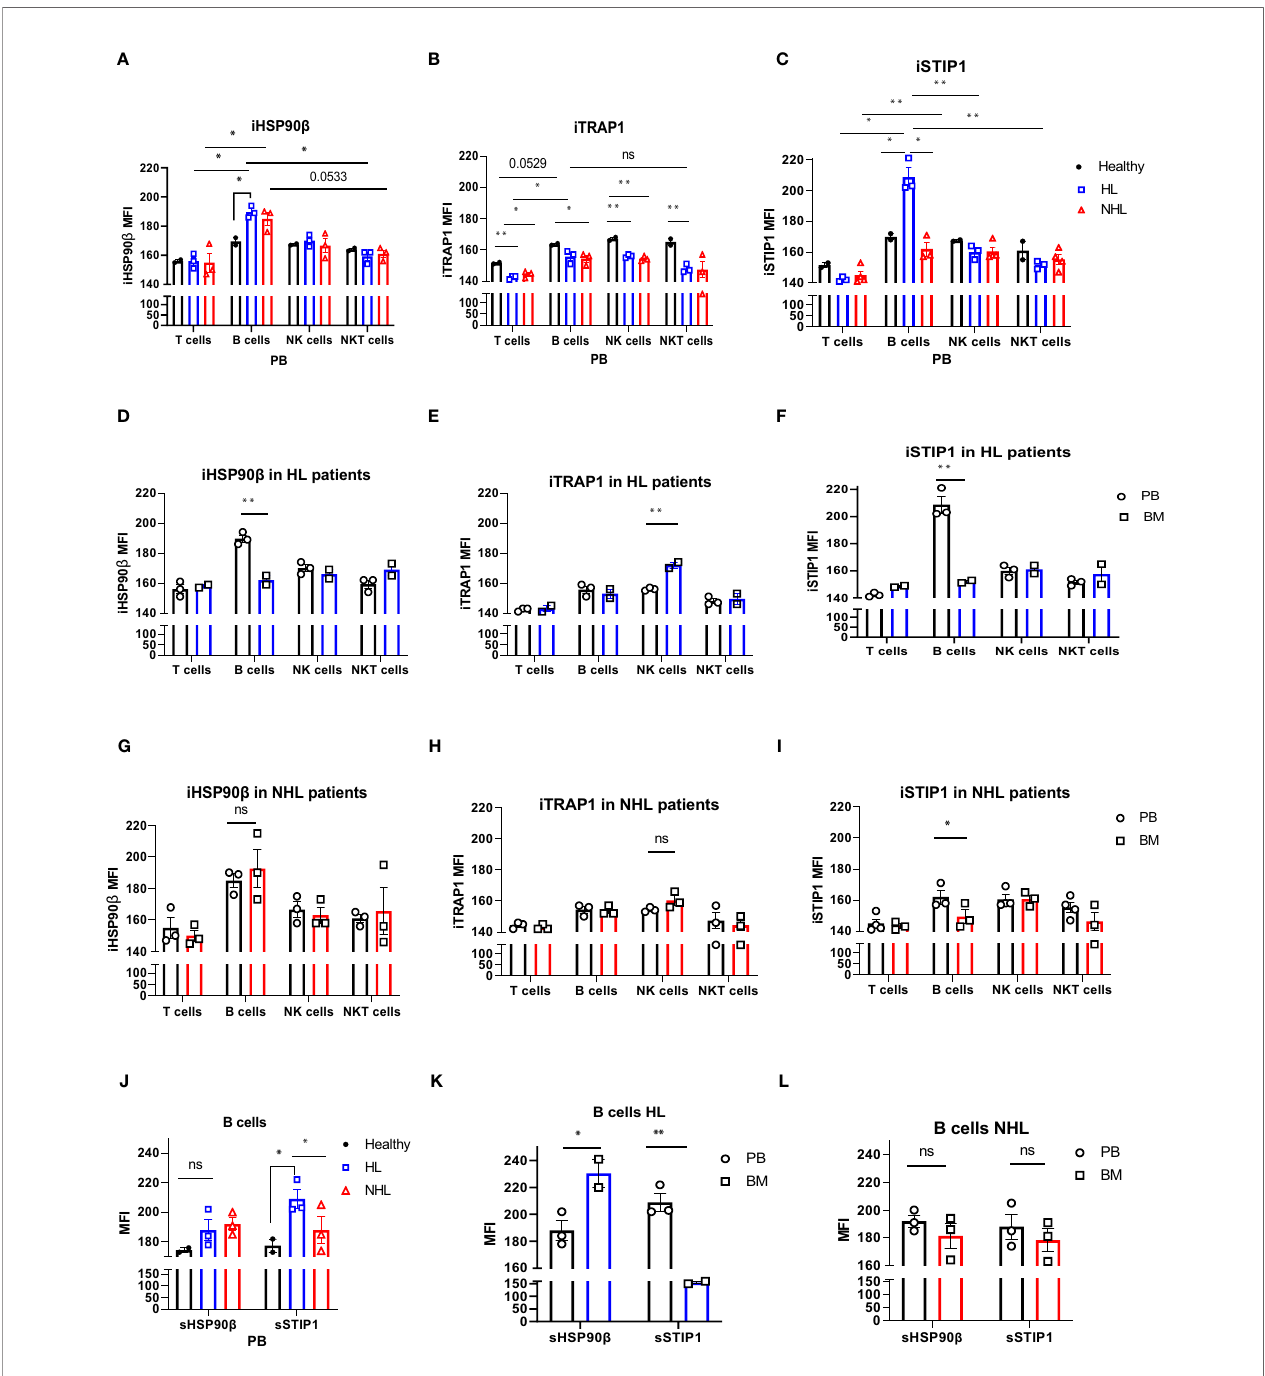
FIGURE 2 | Intracellular and surface HSP90 b , TRAP1 and STIP1 expression in PB- and BM- derived lymphocytes of lymphoma patients. The mean level of intracellular expression of HSP90 b (iHSP90 b ) (A) , iTRAP1 (B) and iSTIP1 (C) (as mean fl uorescence intensity; MFI) in lymphocytes derived from PB of HL (n=3), NHL (n=3) patients and healthy controls (n=2). The expression of iHSP90 b (D) , iTRAP1 (E) and iSTIP1 (F) in lymphocytes derived from BM of HL (n=2) and iHSP90 b (G) , iTRAP1 (H) and iSTIP1 (I) in NHL (n= 3) patients. (J – L) Surface HSP90 b and STIP1 expression in B lymphocytes derived from PB and BM samples of lymphoma patients. (J) The expression of sHSP90 b and sSTIP1 in B cells derived from PB of HL (n=3), NHL patients (n=3) and healthy controls (n=2). (K) The expression of sHSP90 b and sSTIP1 in B cells derived from PB and BM of HL (n=2). (L) The expression of sHSP90 b and sSTIP1 in B cells derived from PB and BM of NHL (n=3) patients. Graphs show mean ± SEM. ns, not signi fi cant, *p<0.05, **p<